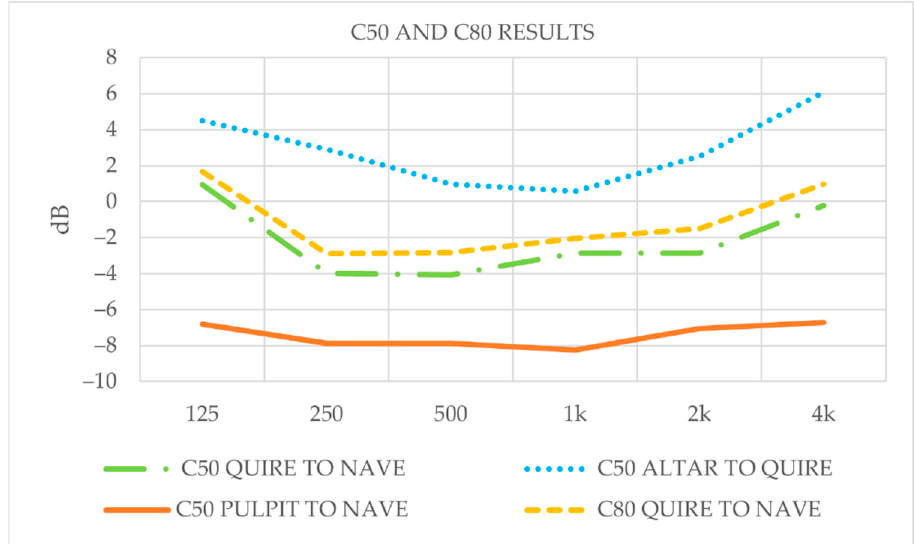
( b ) Figure 9. mid-frequency [500 Hz–1 kHz] T30 results: ( a ) T30 results over receiver positions; ( b ) T30 results over distance.